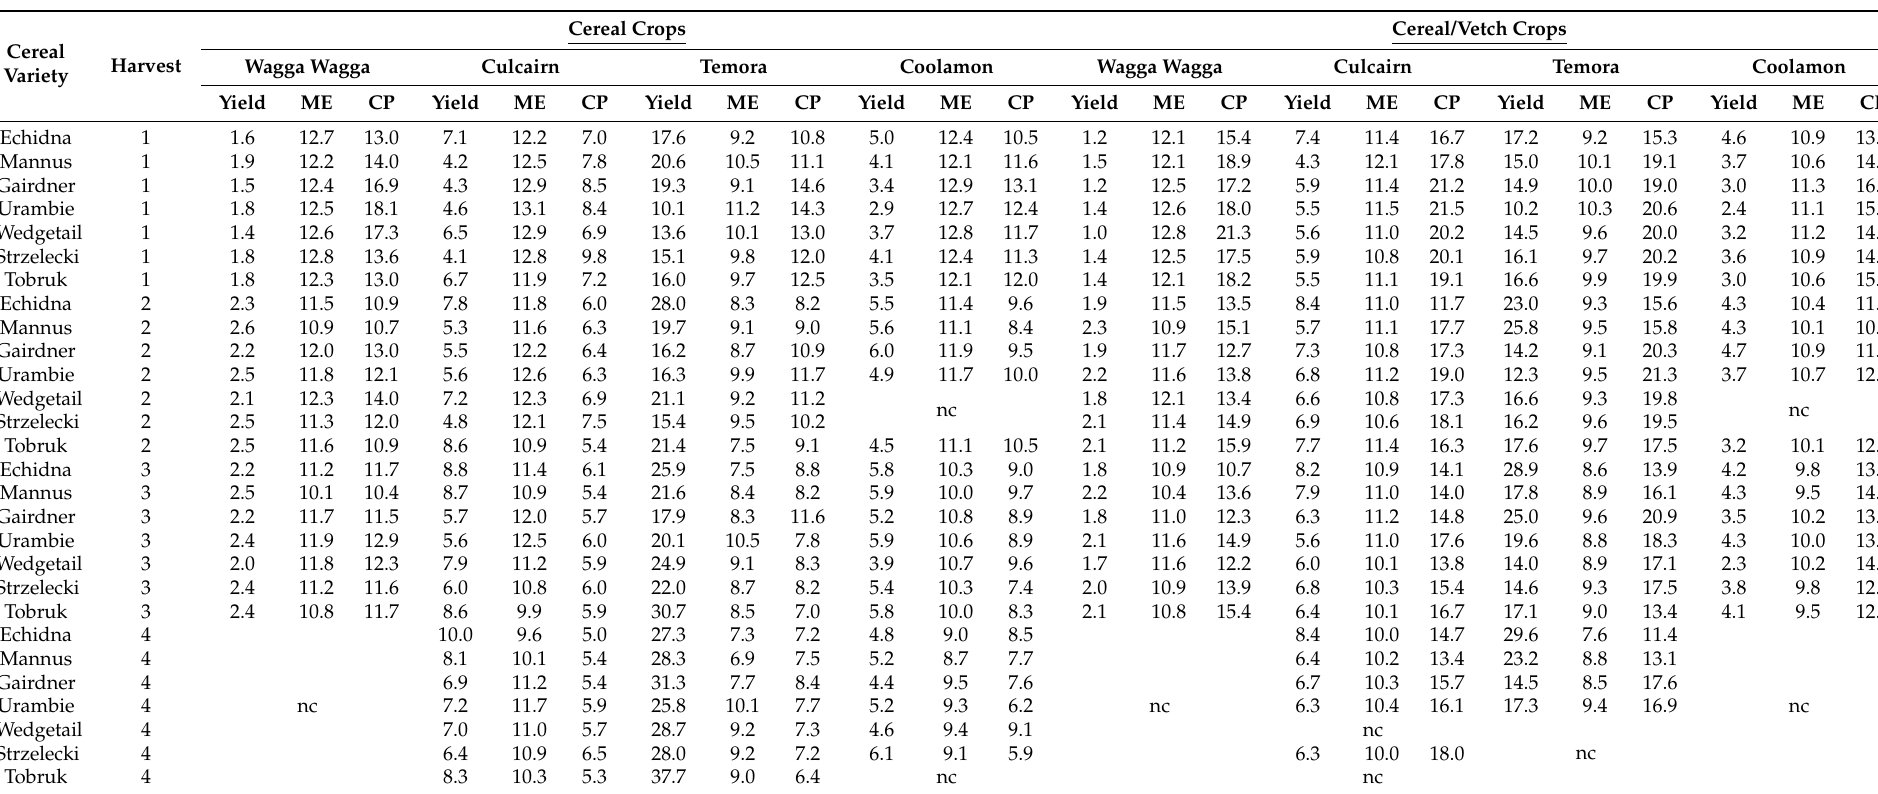
Table 2. Yield (t DM/ha), metabolisable energy (ME: MJ/kg DM) and crude protein (CP: g/kg DM) content of cereal and cereal/vetch forages grown in New South Wales, Australia at Wagga Wagga in 2008, Culcairn in 2009, Temora in 2010, and Coolamon in 2011. Cereal